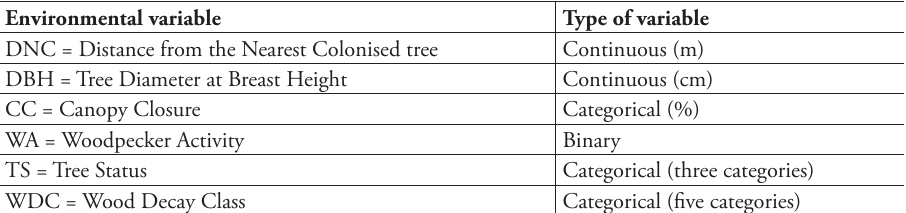
Table 3. Environmental variables collected on wild trees and logs. Environmental